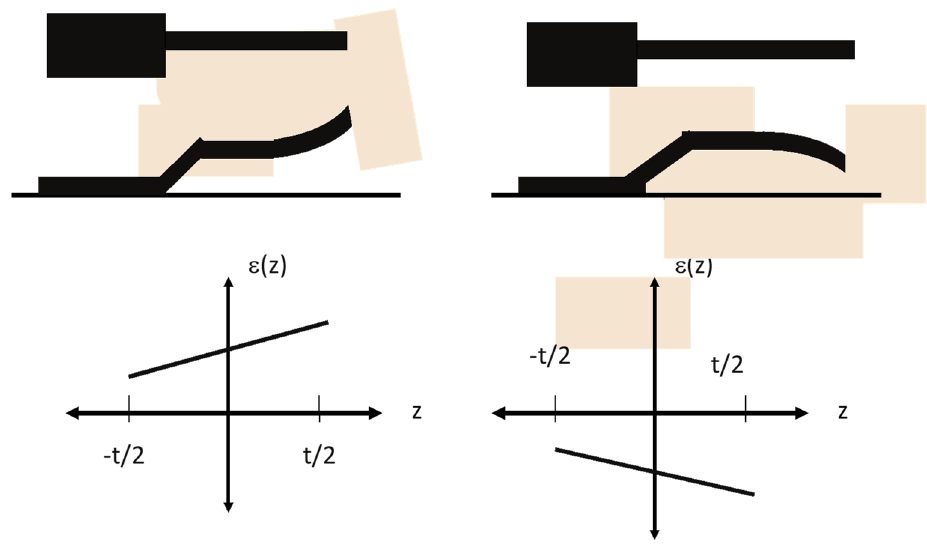
Figure 15. Illustration of stress gradients in cantilevers exhibited as strain gradients that can be used to measure the stress gradient in material layers. The plan and cross-sectional views of the cantilevers are at the top and the strain as a function of the cantilever thickness is given at the bot- tom.